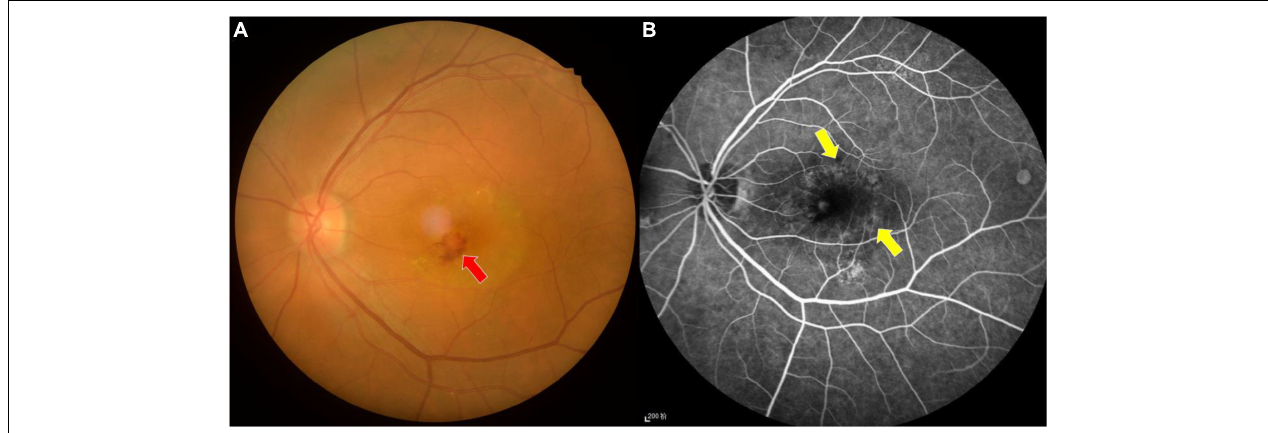
FIGURE 1 | Fundus photograph (A) and fluorescence fundus angiography image (B) of age-related macular degeneration. The fundus photograph shows bleeding and exudation in the macular area, while the leakage of strong fluorescein spot and shadowing fluorescein at the macular area are shown in the fundus fluorescein angiography image. Red arrow indicates bleeding, and yellow arrows indicate the leakage.